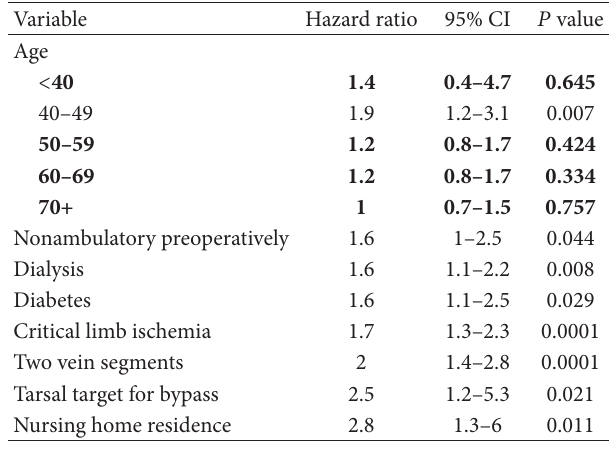
T 2: Multivariate predictors of amputation or gra occlusion 1 year following lower extremity bypass.